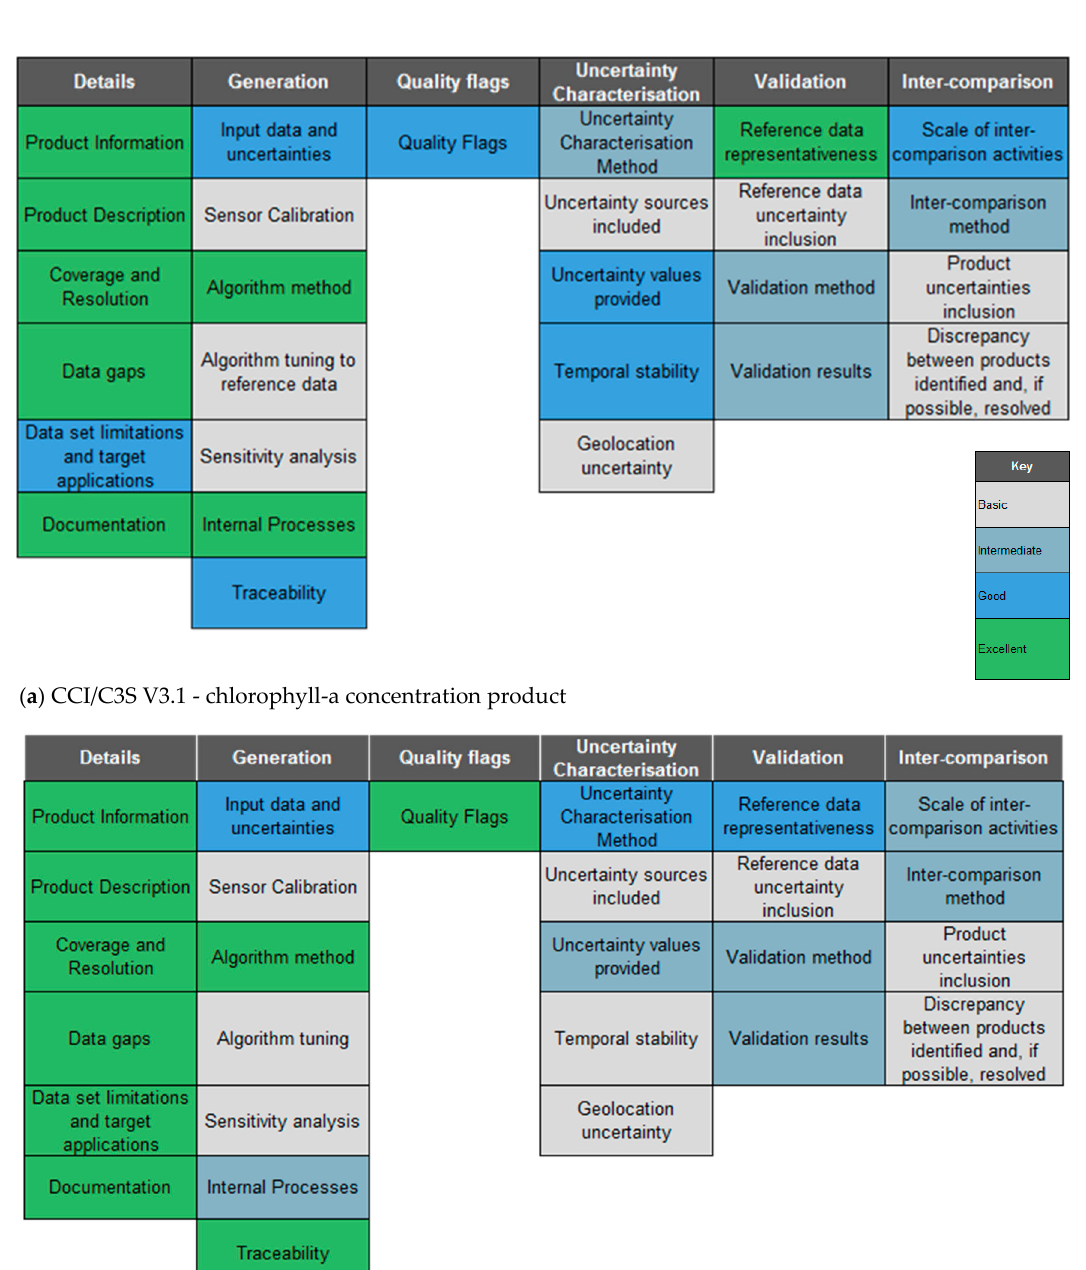
8 of 24 Figure 2. Example of the evaluation questions within the Uncertainty Characterisation Quality Indicator (QI) section that an independent expert Reviewer would answer based on the information provided by the product producer in the QAT. Similar to the evaluation process developed for QA4ECV [3], the EQC evaluation only assesses the fraction of information provided relative to all questions and reviewer assessment of information provided. Four levels of achievement ranging from Basic, Intermediate, Good and Excellent are defined. To achieve a rating of Excellent, almost all QI details per individual section must be provided with substantial credible detail, while a score of Basic would indicate that minimal explanation of a QI was provided and that good practices (if currently available) were not necessarily followed. Figure 3 shows an example of the Quality Evaluation Matrix (QEM) results summary achieved for two Ocean Colour data products. This evaluation indicates the QI sections where sparse information was